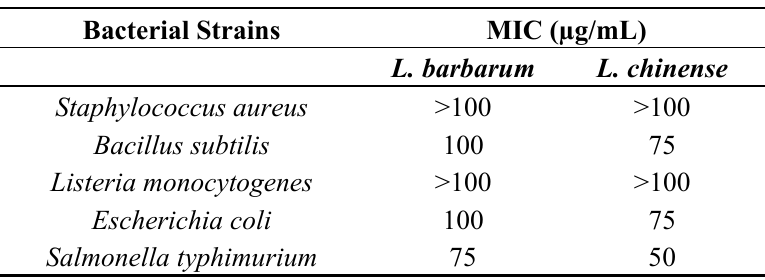
Table 5. Minimal Inhibitory Concentration (MIC) of both L. barbarum and L. chinense